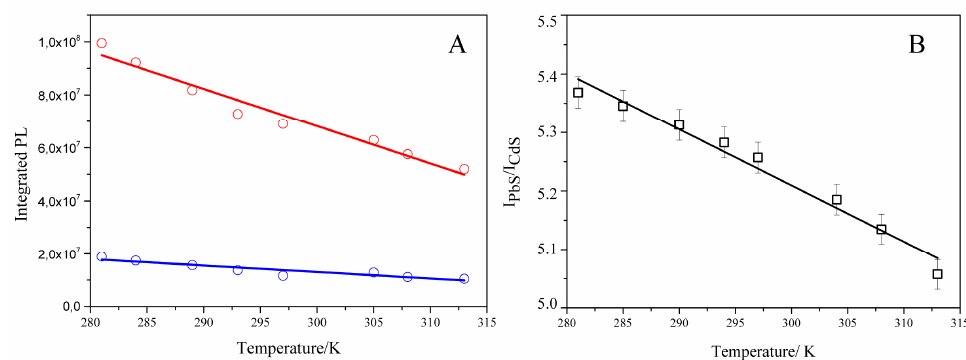
Figure 5. Scatter plot and line fit of ( A ) integrated fluorescence of CdS (blue symbol and line, I CdS ) and PbS (red symbol and line, I PbS ) versus temperature and ( B ) ratiometric response (I PbS / I CdS ) versus temperature.